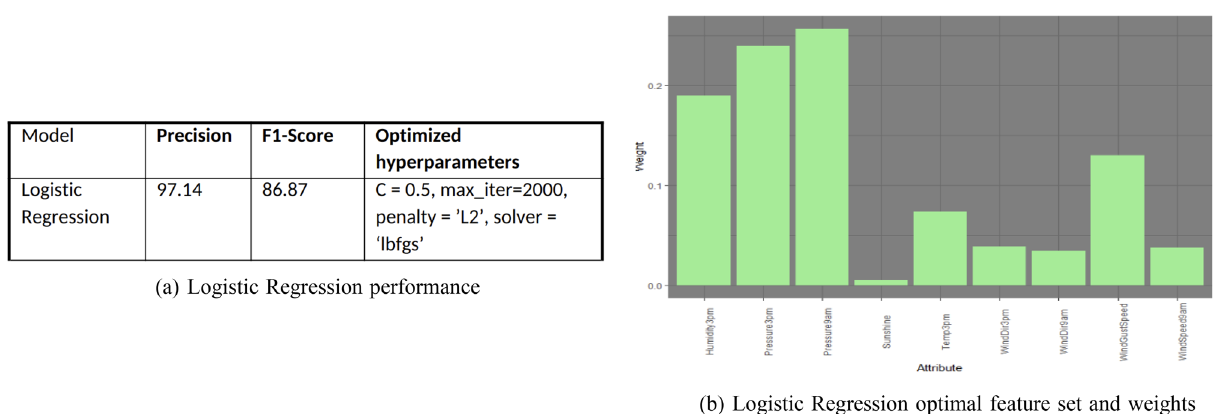
Figure 10. Logistic regression performance and feature